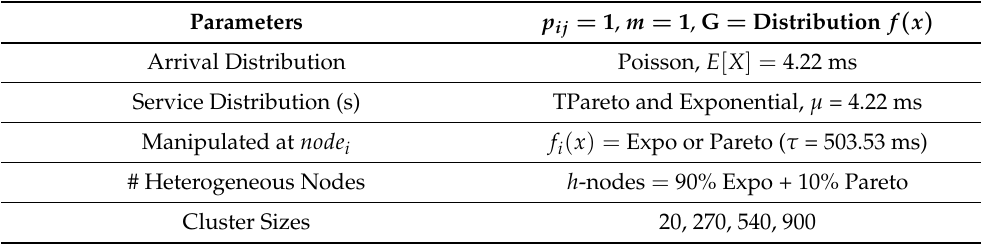
Figure 8. HFJQNs of applying 90% homogeneous (exponential) and 10% inhomogeneous (bounded Pareto) for all fork nodes, where the white- and black-box methods’ prediction performance results are compared at load 90%. Table 4. Portions of homogeneous and inhomogeneous